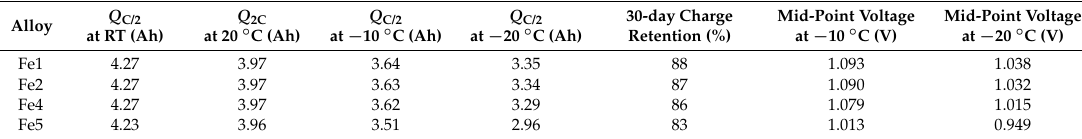
Figure 3. The discharge voltage curves obtained using a rate of C/2 at ( a ) − 10 °C and ( b ) − 20 °C; ( c ) a summary of the discharge capacity and mid-point voltage at − 10 °C and − 20 °C; and ( d ) 30-day capacity retention at RT for cells Fe1, Fe2, Fe4 and Fe5. Table 2. Summary of discharge capacities at different rates and temperatures, mid-point voltages at different temperatures and 30-day charge retention. Q C/2 and Q 2C are the discharge capacities measured at C/2 and 2C, respectively.